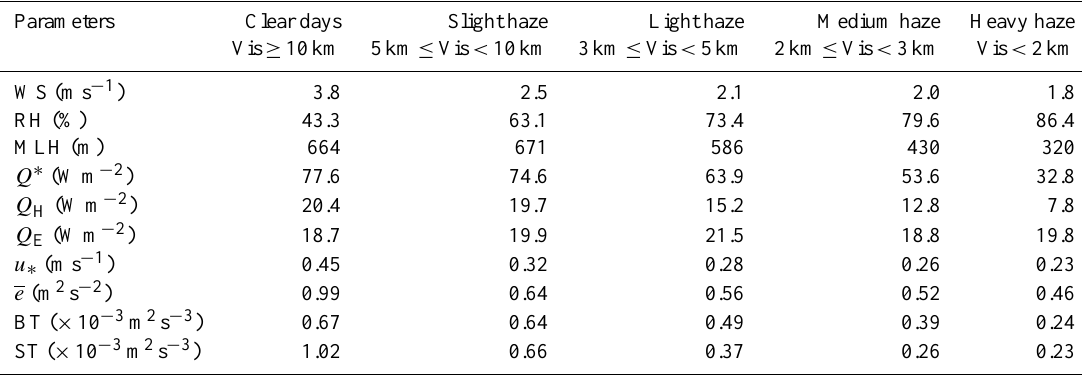
Table 2. Statistics of the thermal/dynamic parameters under different degrees of air pollution. Parameters Clear days Slight haze Light